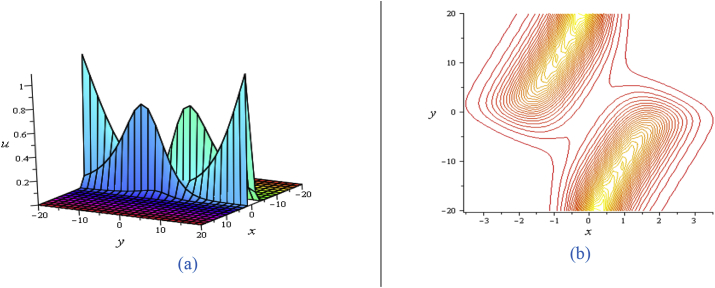
Profile of the Eq. (18) for ℓ1=ℓ2=2,σ1=σ2=0,σ4=0.05,w1=σ=1,η=0.05,δ=3:(a) 3D plot (left), (b) contour plot (right) at t = 0.